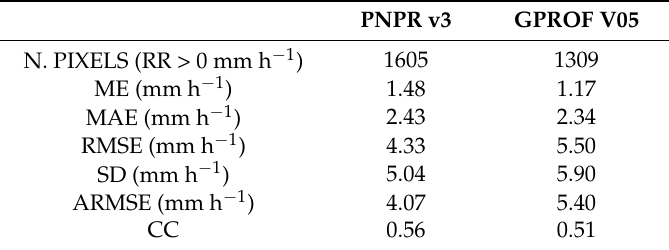
Table 10. Same as Table 8 but, for the GMI overpass at 16:35 UTC on 9 August 2015.